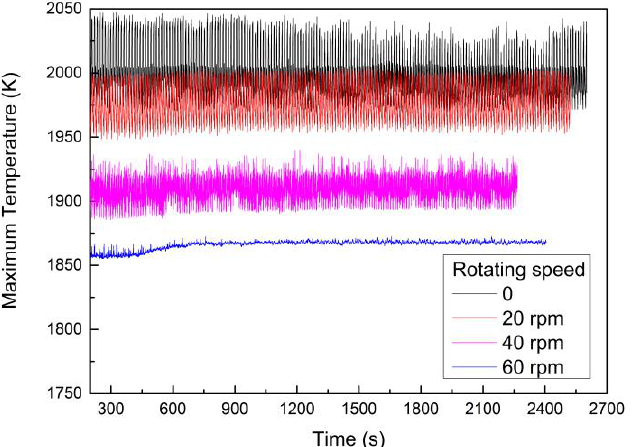
Figure 7. Time variation of maximum temperature of the melt with the electrode rotating at different speeds.